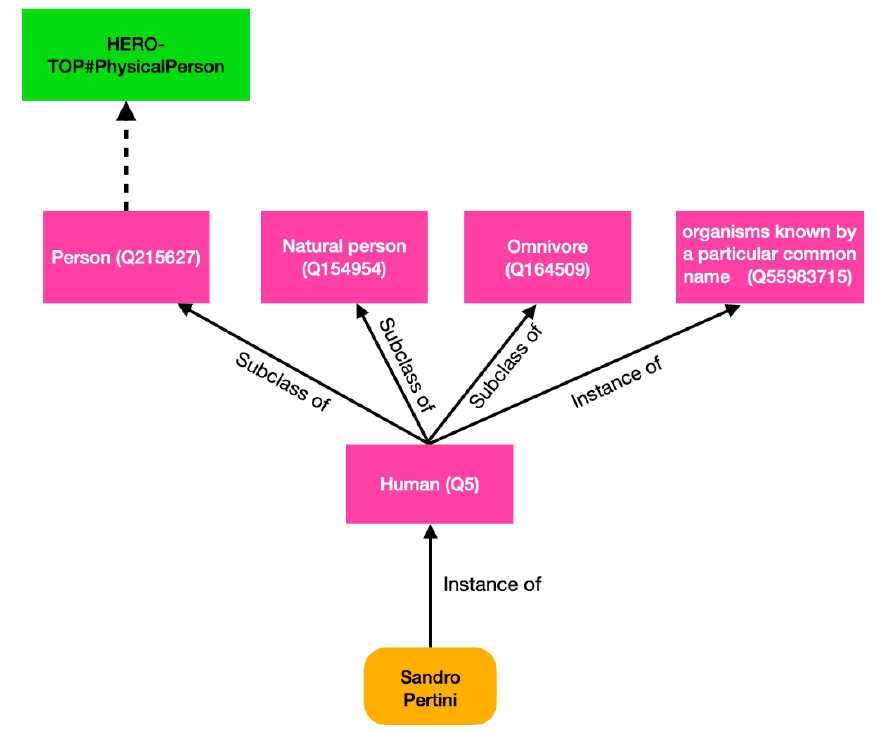
Figure 6. Partial representation of the parents of the human (Q5) Wikidata category. Orange boxes represent Wikidata entities, pink boxes represent Wikidata categories, and green boxes represent HERO classes. Dashed arrows represent mappings between Wikidata and HERO categories.